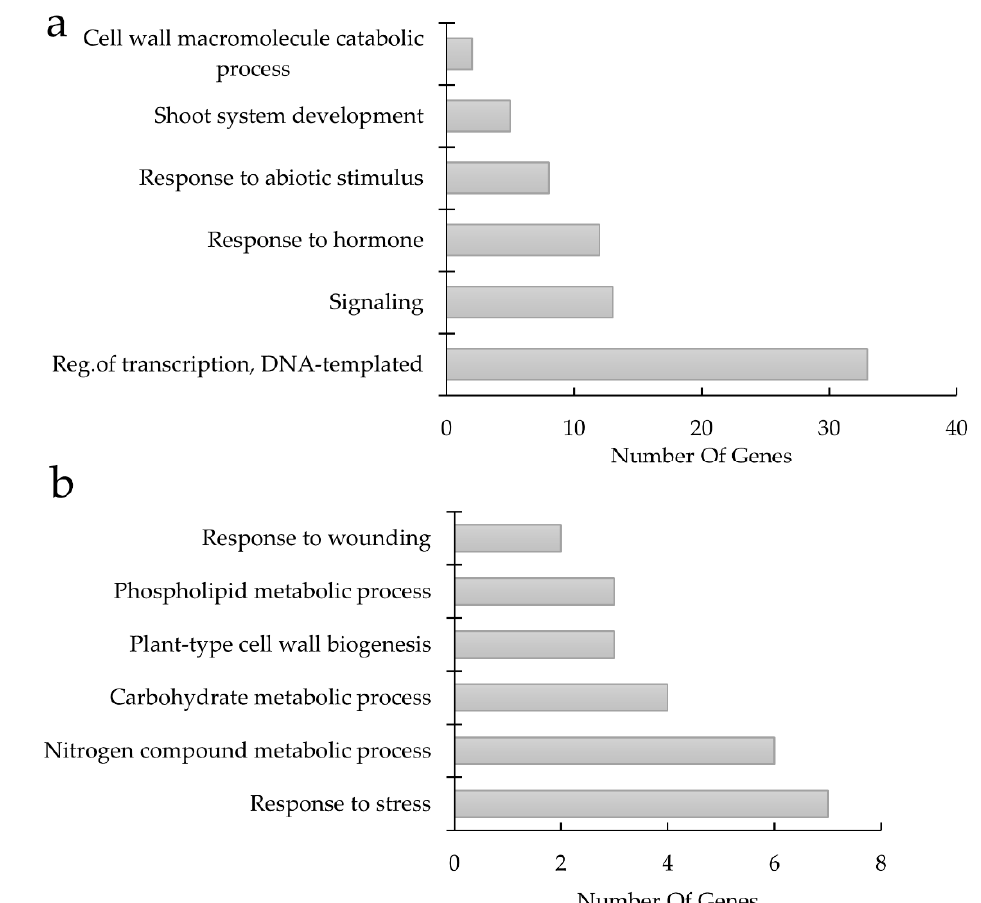
Figure 6. Compatible [Momotaro shoot (Momo)/TTM-079 (TD1) and Momo/Momo] and incompatible grafted lines [Momo/green force (GF)] show differentially expressed genes revealed by transcriptomic analysis. Gene ontology (GO) analysis classification on ( a ) reduced gene expression on DEGs by Momo/GF (fold change ≥ 2, Momo/TD1, Momo/Momo vs. Momo/GF) and ( b ) increased gene expression on DEGs by Momo/GF (fold change ≤ 0.5, Momo/TD1, Momo/Momo vs. Momo/GF). The x axis shows the number of genes of each GO cluster classification, and the y axis shows the GO ontology term. Table 2. List of differentially expressed genes with potential significance to identify compatible grafts [Momotaro (Momo)/TTM-079 (TD1) and Momo/Momo] vs incompatible [Momo/green force (GF)] lines.